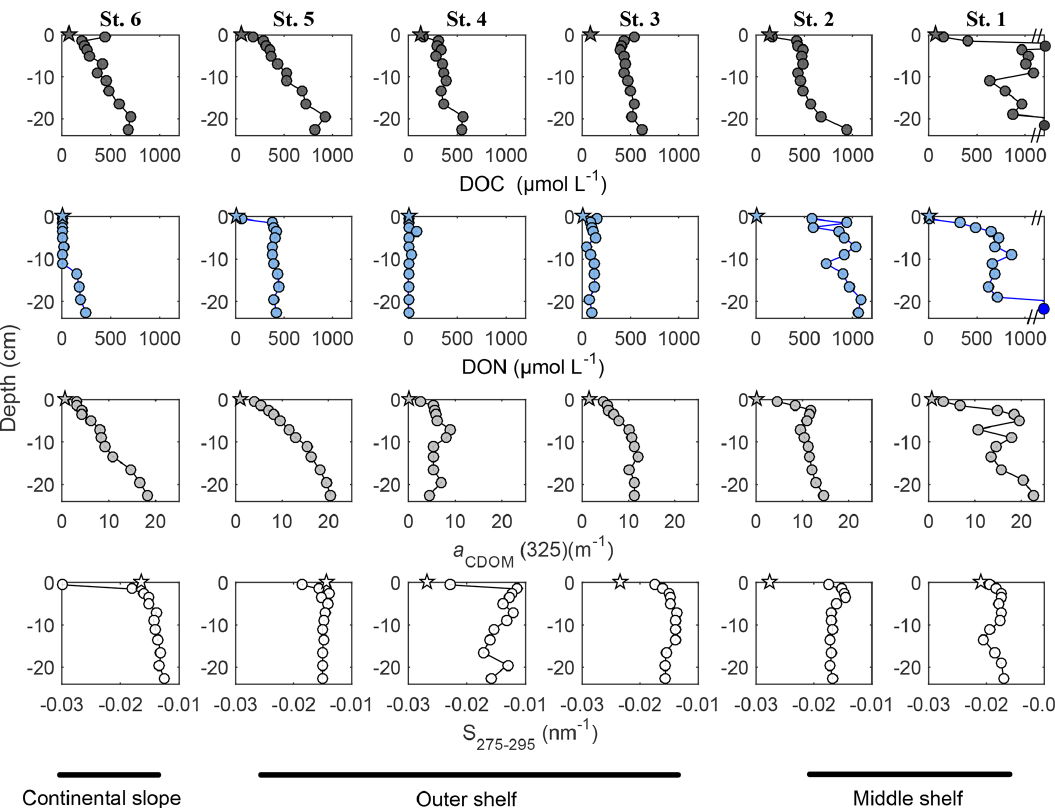
Figure 2. Pore water DOC (dark grey symbols), DON (blue symbols), a CDOM ( 325 ) (light grey symbols) and S 275 − 295 (white symbols) distribution within the sediment pore waters: depth profiles. Circles represent concentration/value, measured in the pore water sample; stars represent the initial concentration/value within BIGO chambers. DOC concentrations after axis break are 2010 and 2568µmolL − 1 at 3 and 22cm sediment core depth, respectively. DON concentration after axis break is equal 2807µmolL −